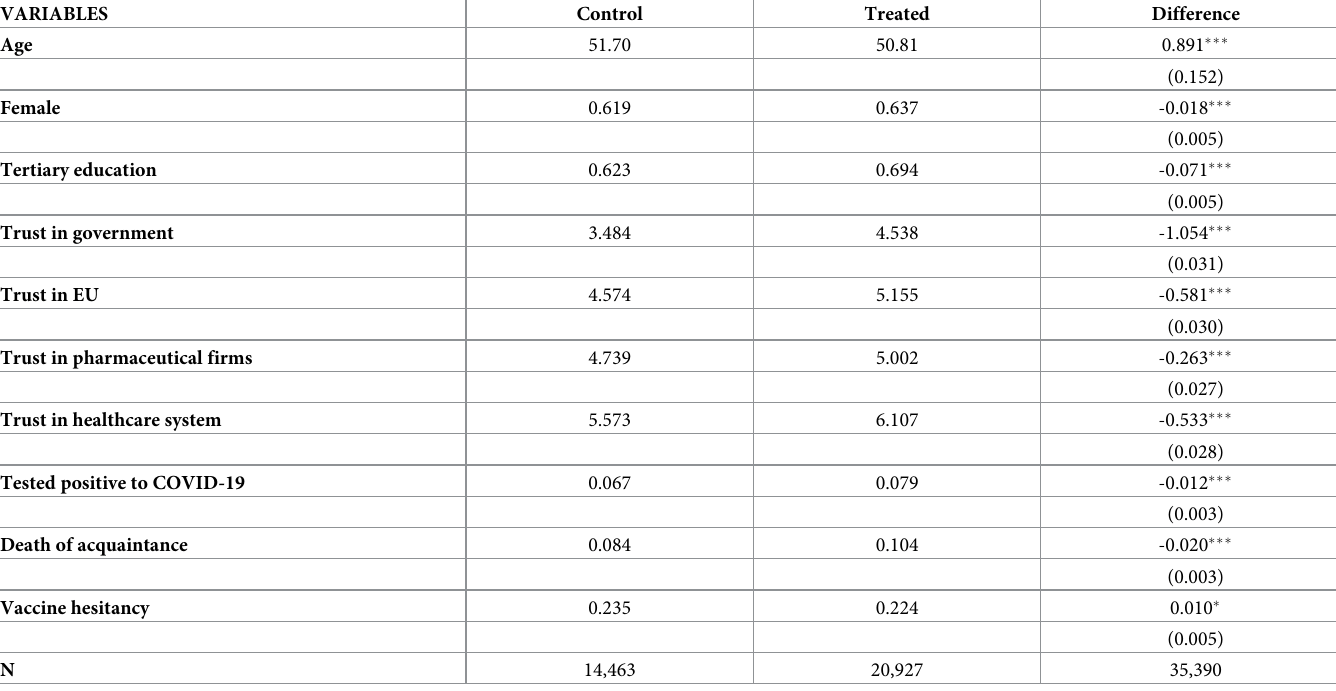
Table 2. Differences between treated and control